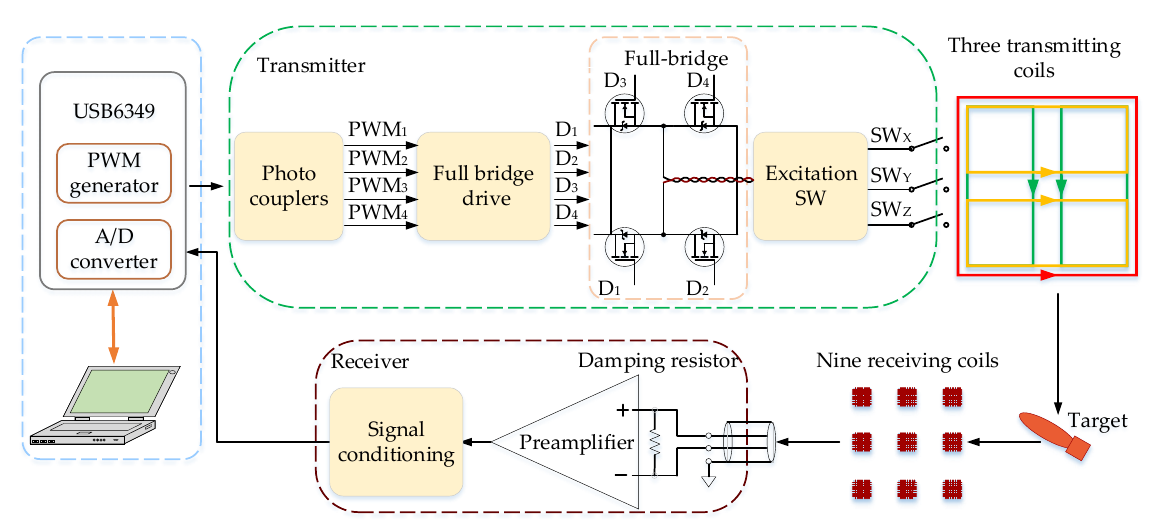
Figure 1. Schematic diagram of the towed system.